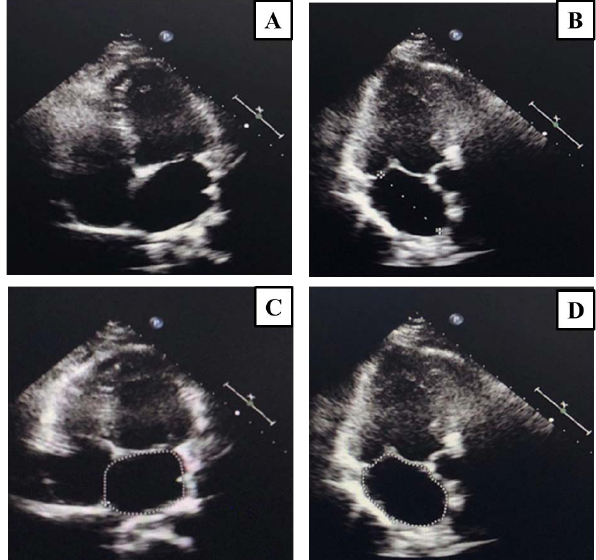
Figure 1: Measurement and calculation of left atrial volume(A: the distance from the top of the left atrium to the midpoint of the line between the mitral annulus; B: t he distance from the top of the left atrium to the midpoint of the line between the mitral annulus; C: outline the left atrium volume corresponding to L1; D outline the area of the left atrium corresponding to